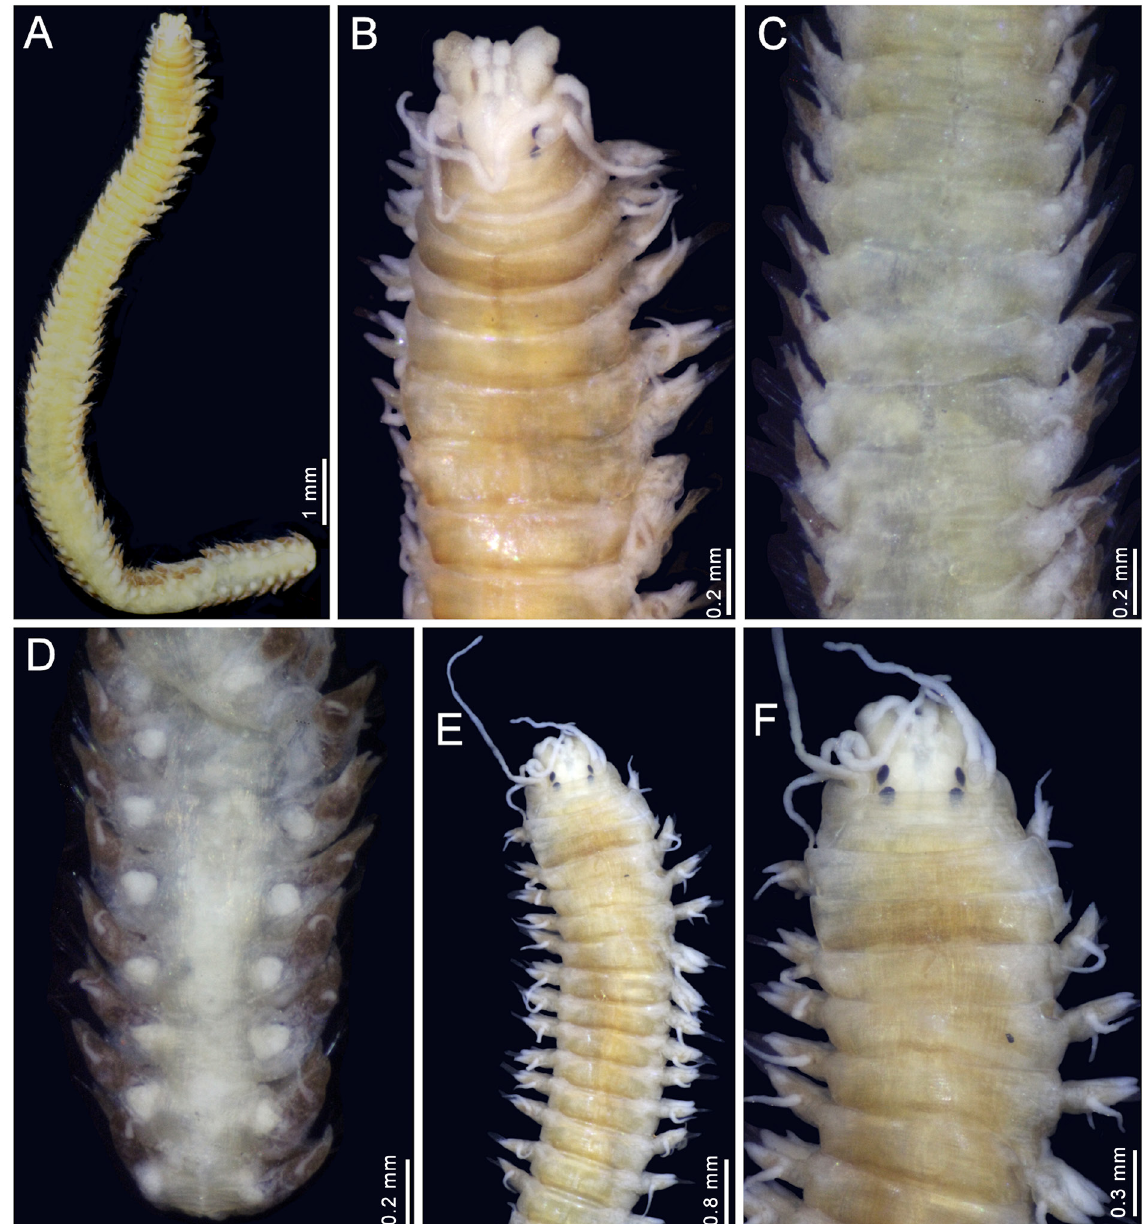
Fig. 19. Nereis mezianei sp. nov., paratypes (MNHN 372-4b). A . Smallest paratype, dorsal view. B . Same, anterior end, dorsal view. C . Same, median segments, dorsal view. D . Same, posterior region, dorsal view. E . Largest paratype, anterior region, dorsal view. F . Same, anterior end, dorsal